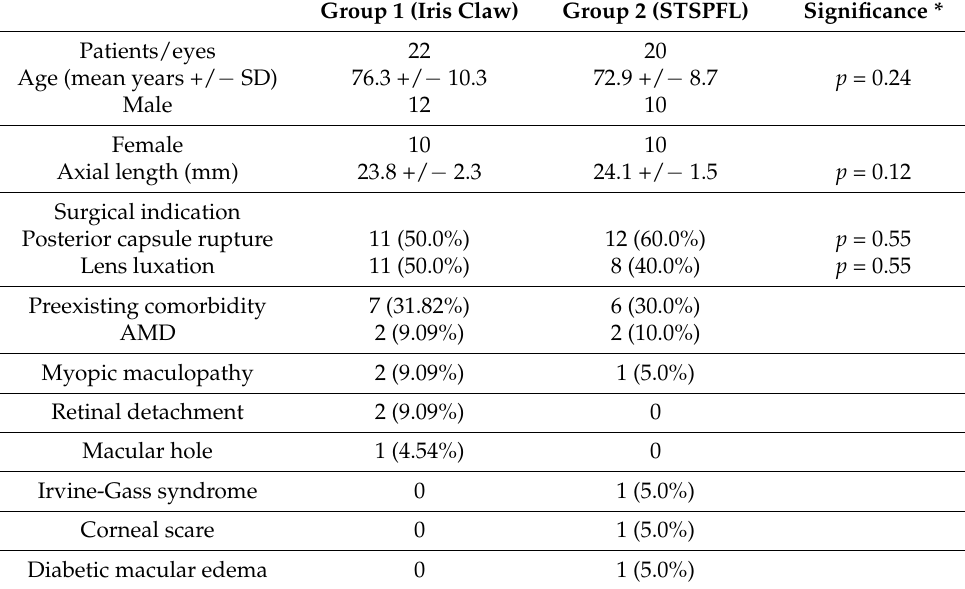
Table 1. Demographic and clinical characteristics of study